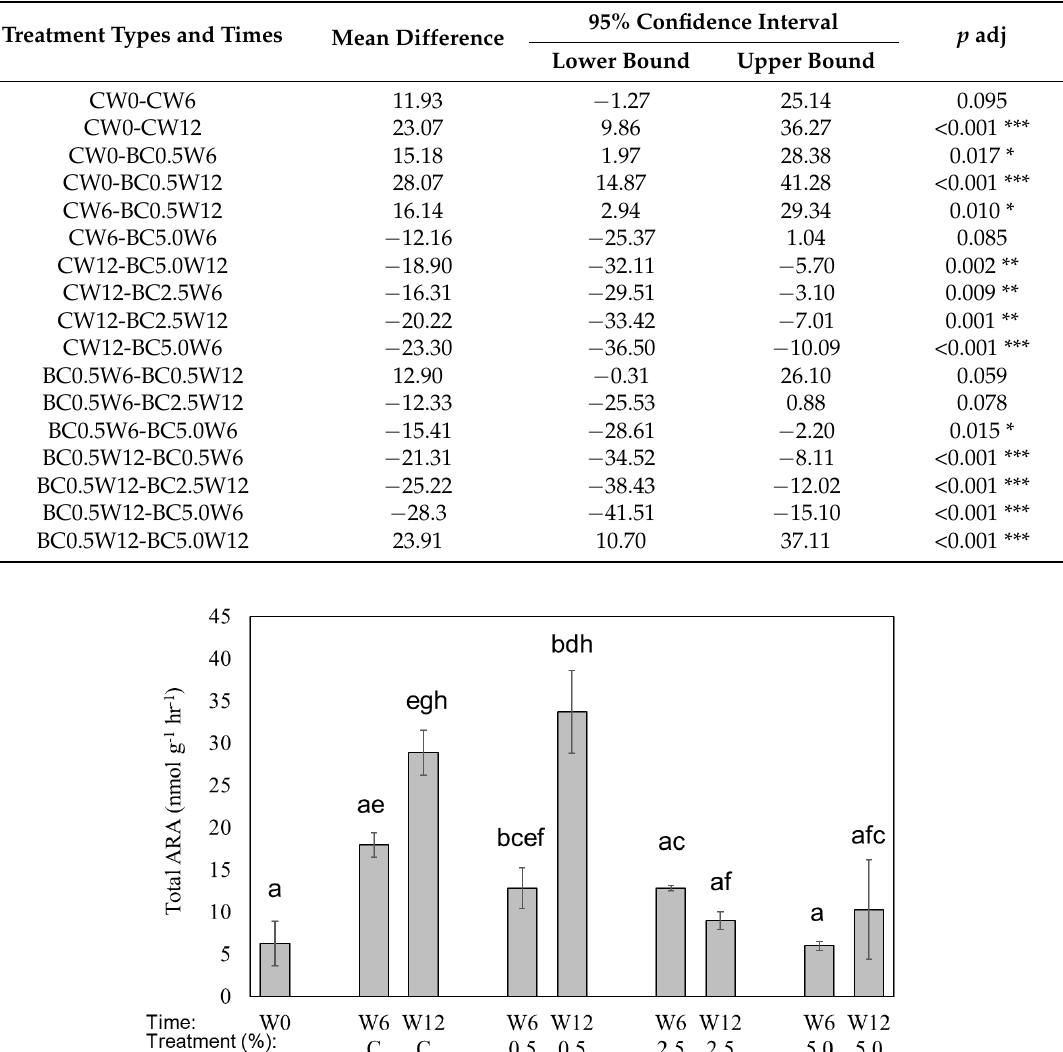
Figure 6. Effects of different amount of biochar addition to soils on N 2 fixing potentials based on acetylene reduction. Statistically significant differences ( p < 0.05) are indicated by different letters. n = 3, ±SD. Table 1. Statistical data of potential biological N 2 fixation (BNF) rates between treatments and times. Single factor ANOVA (analysis of variance), where * represents p < 0.05, ** p < 0.01, and *** p < 0.001. All data not presented in the table had no significant differences ( p > 0.1), numbers after W represents the number of weeks the experiment was carried out at the time of sample collection.